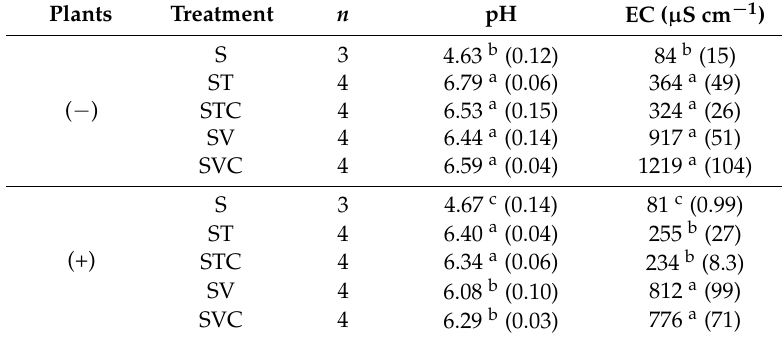
Table 5. Soil pH and electrical conductivity (EC) (µS cm − 1 ) from control soil (S), and control soil amended with thermophilic (T) and vermicompost (V) with and without coir (C) from unvegetated ( − ) and vegetated (+) pots. ( n = number of replicates/pots).